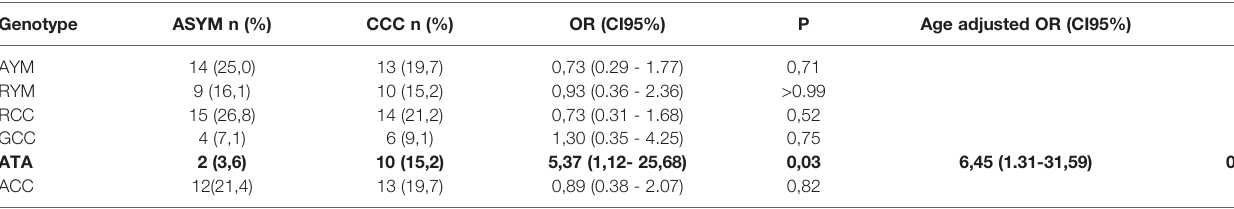
TABLE 3 | Association of the genotypes with CCC in cases and controls.